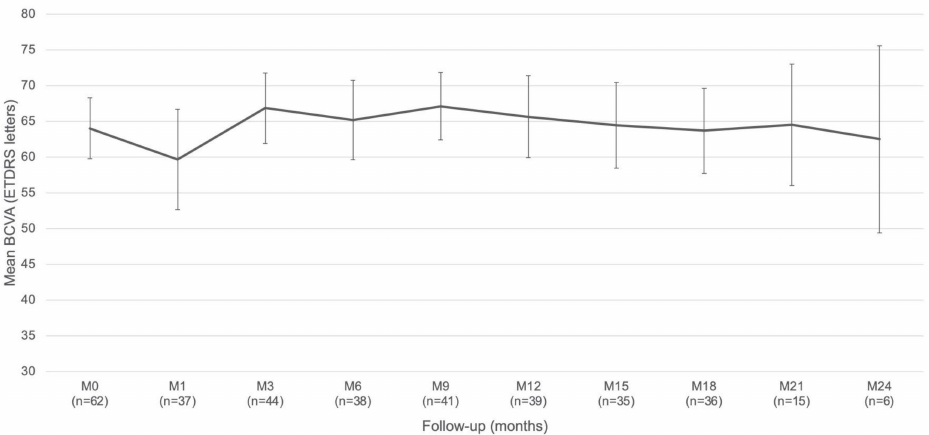
Figure 1. Mean change in best corrected visual acuity (BCVA).